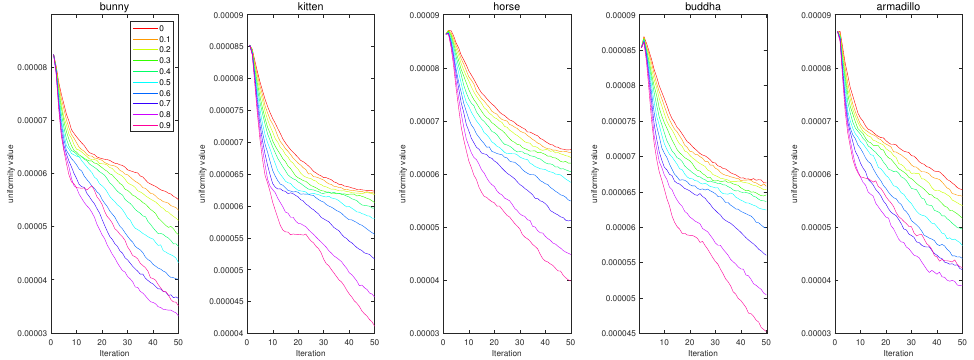
Figure 20. Quantitative performance of the proposed method for various α . The horizontal axis indicates the iteration, and the vertical axis indicates the uniformity value. Each column represents a different input point cloud (first column: Horse, second column: Bunny, third column: Kitten, fourth column: Buddha, and fifth column: Armadillo).